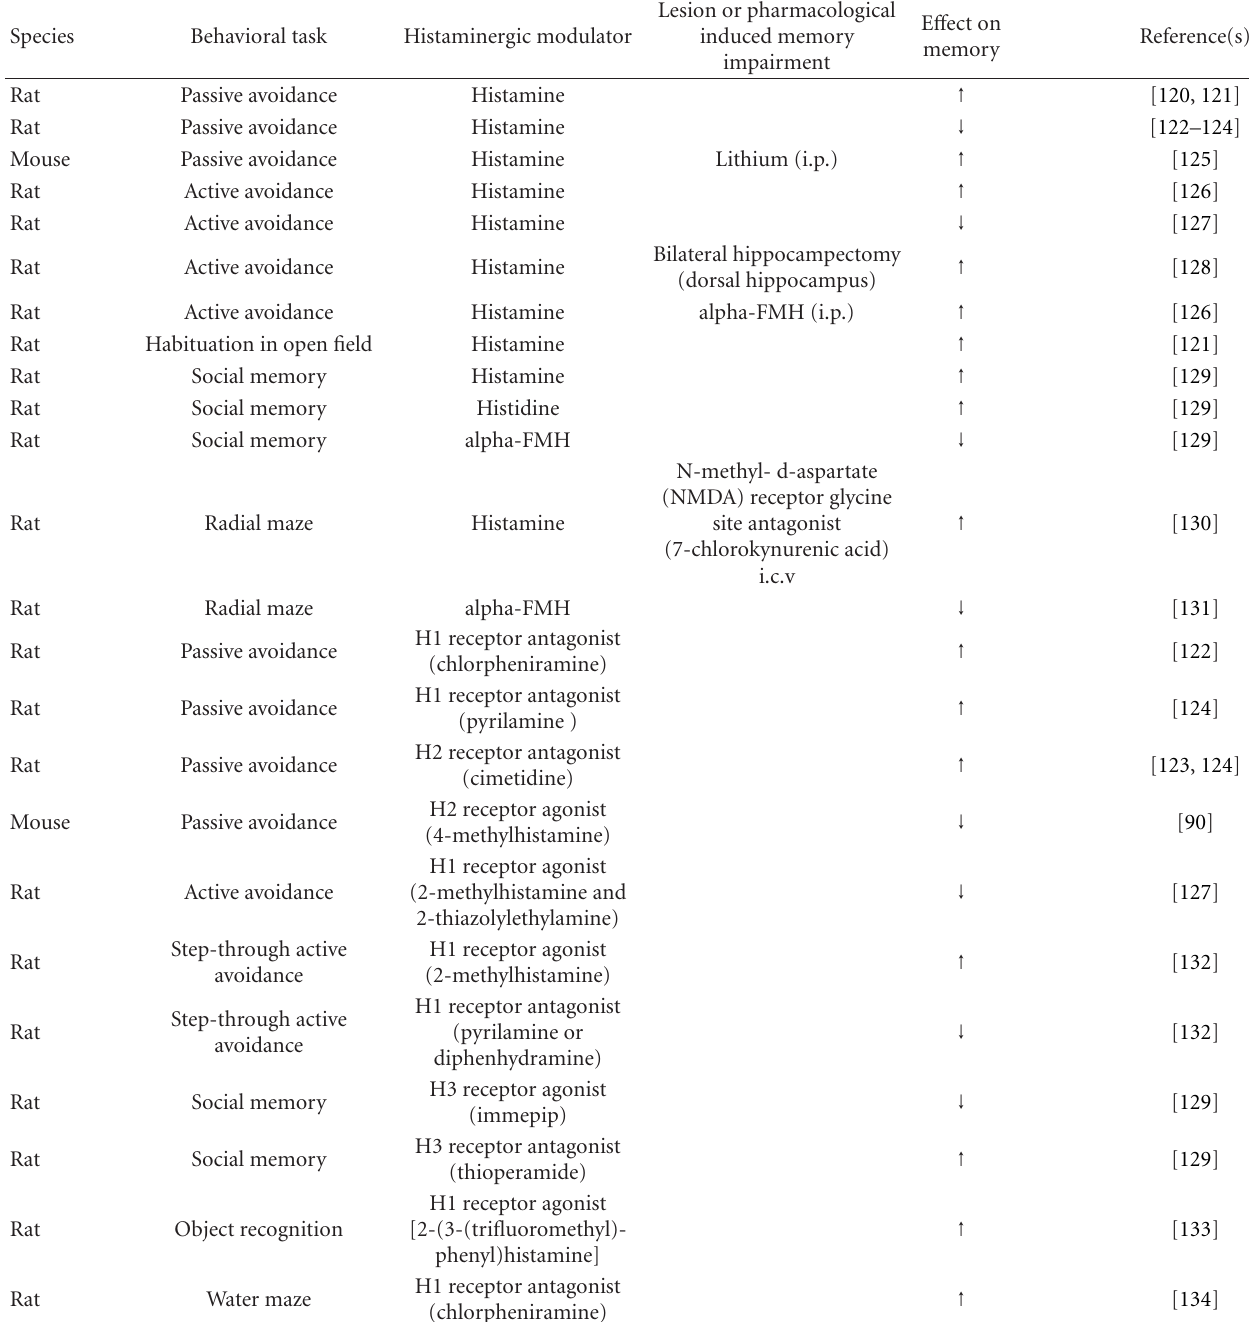
Table 3: Intracerebroventricular administration of drugs that act on the histaminergic system and memory performance.